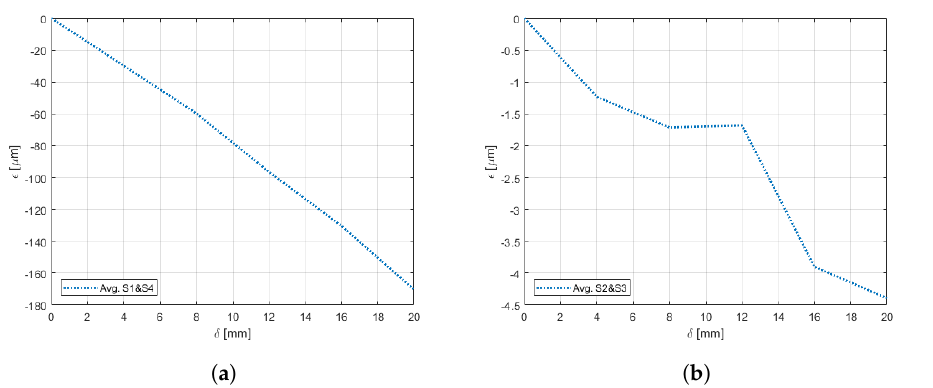
Figure 10. Strain trend in the top section of the wing through sensors ( a ) S 1 and S 4 and ( b ) S 2 and S 3, undergoing bend-up with respect to deflection due to morphing. Separate figures are used due to the large variation in